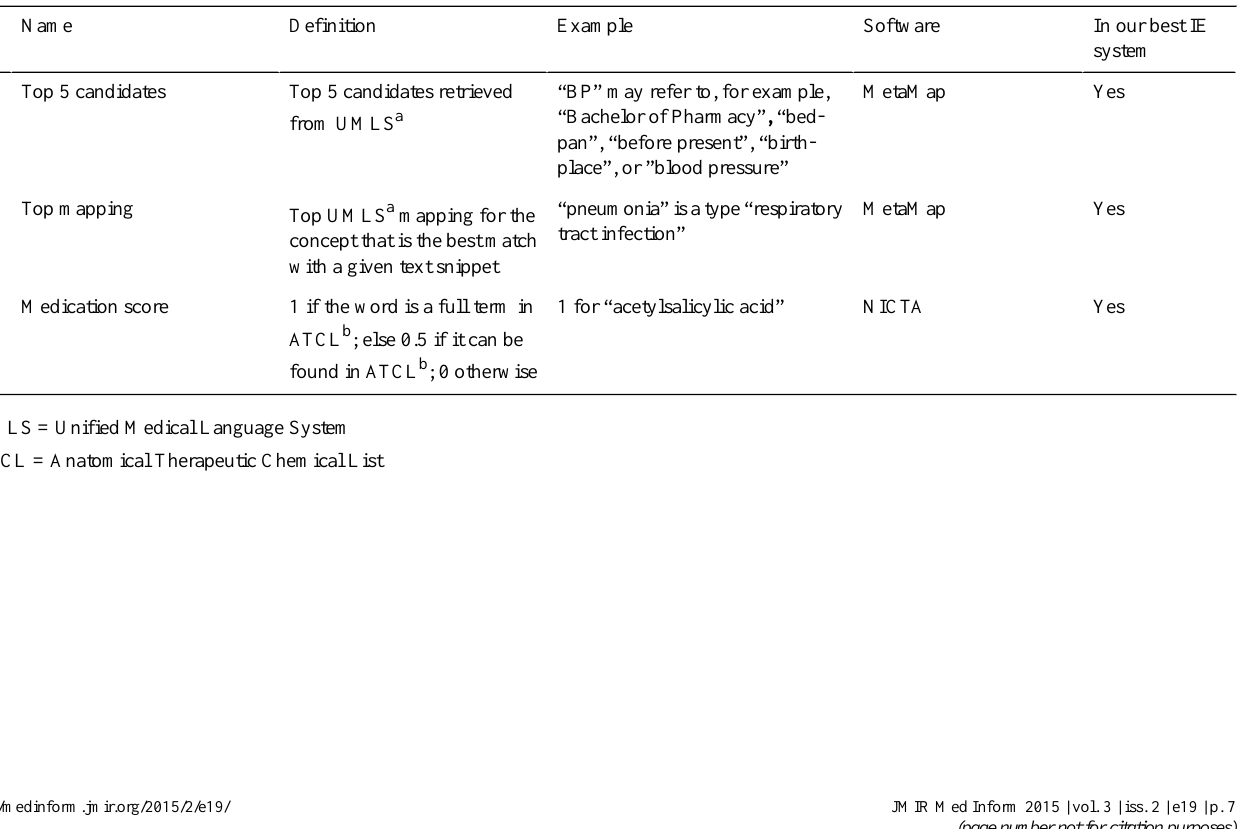
In our best IE systemSoftwareExampleDefinitionNameID